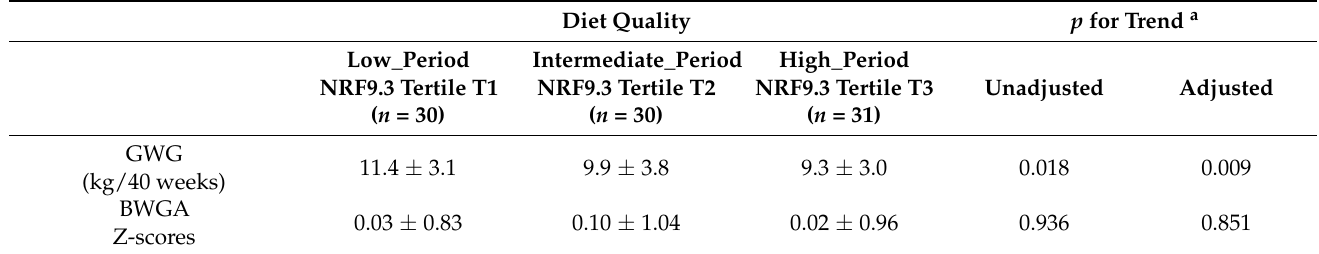
Table 5. Relationship between diet quality assessed by NRF9.3 and GWG or birth weight. Diet Quality p for Trend